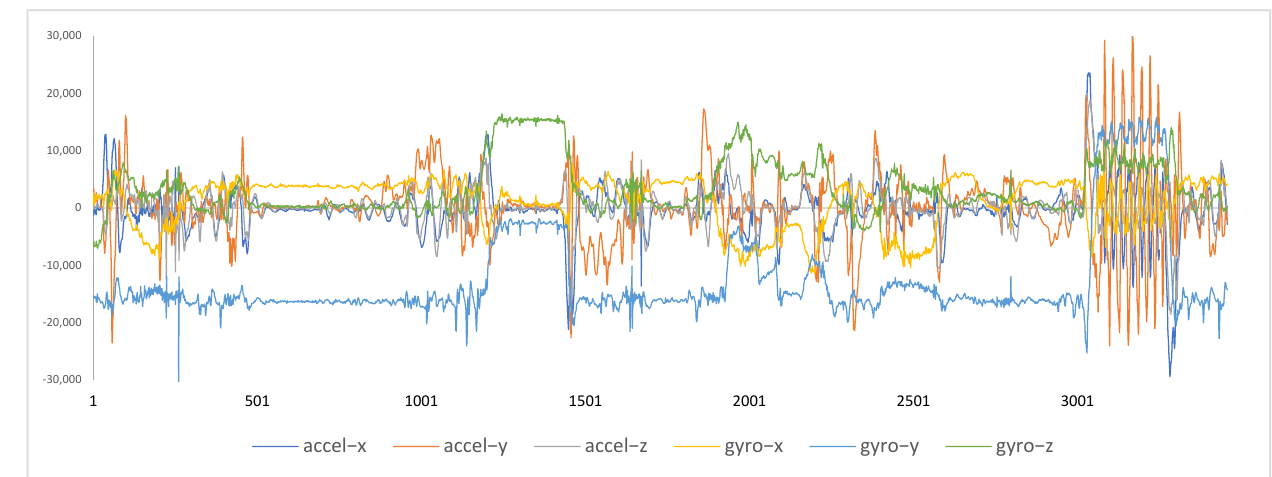
Figure 5. Accelerometer and gyroscope data .